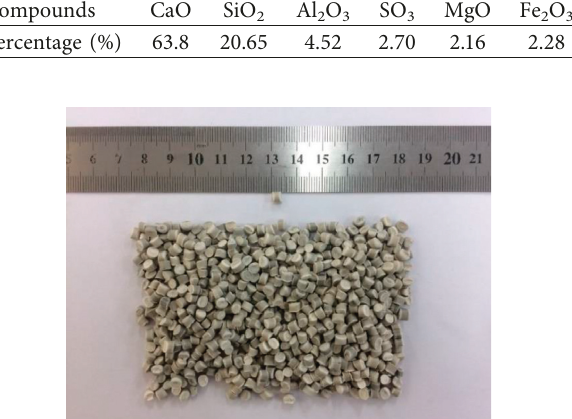
Figure 1: Recycled PP plastic particles with lengths from 2mm to 3.5